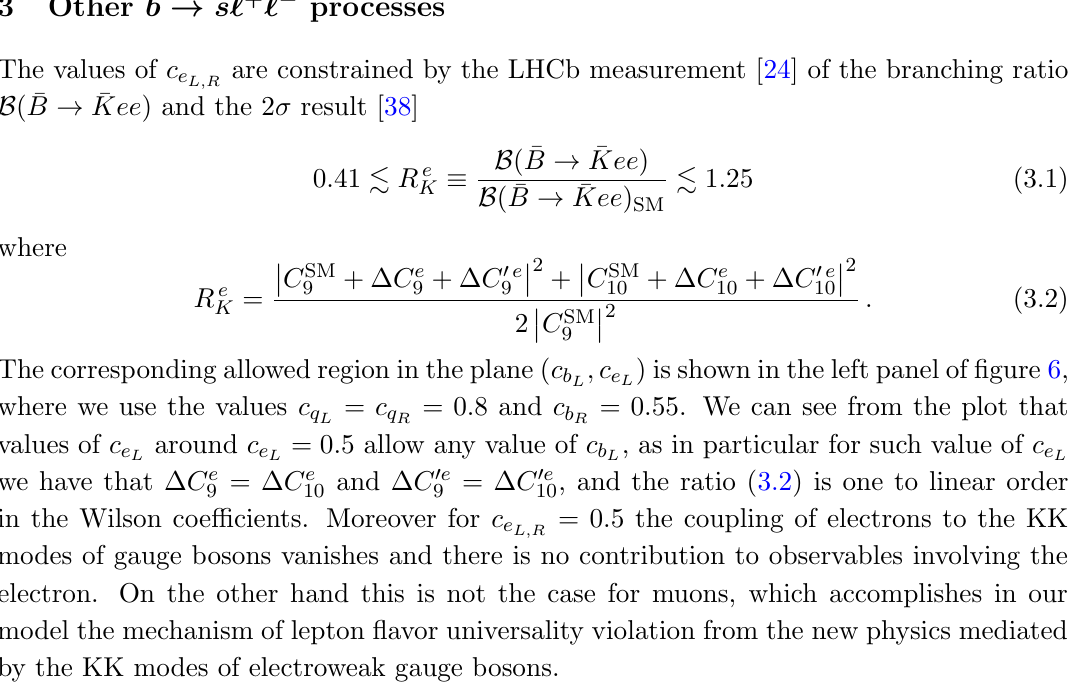
; c (cid:22) ) plane that accommodates the 2 (cid:27) region R K L L = 0 : L